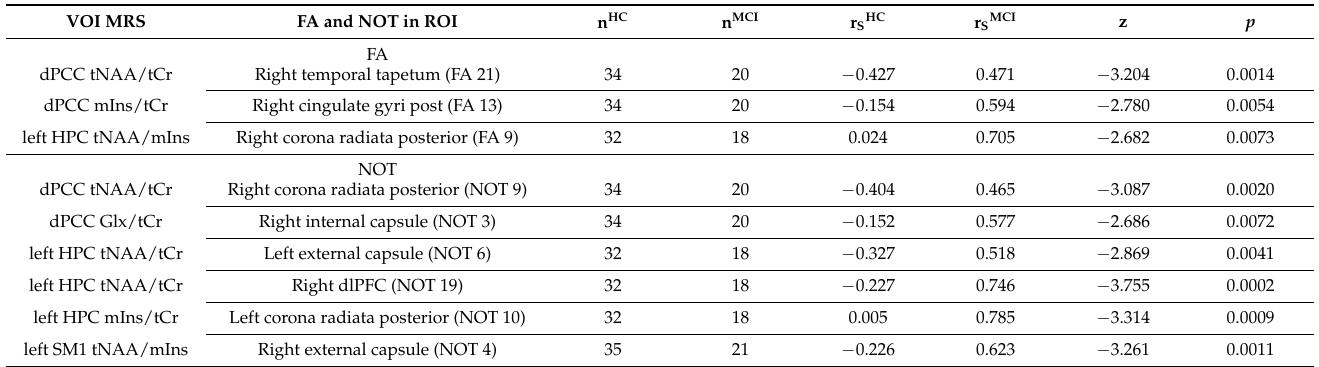
Table 8. Significant group differences in correlations between WM tractographic properties and 1 H-MRS